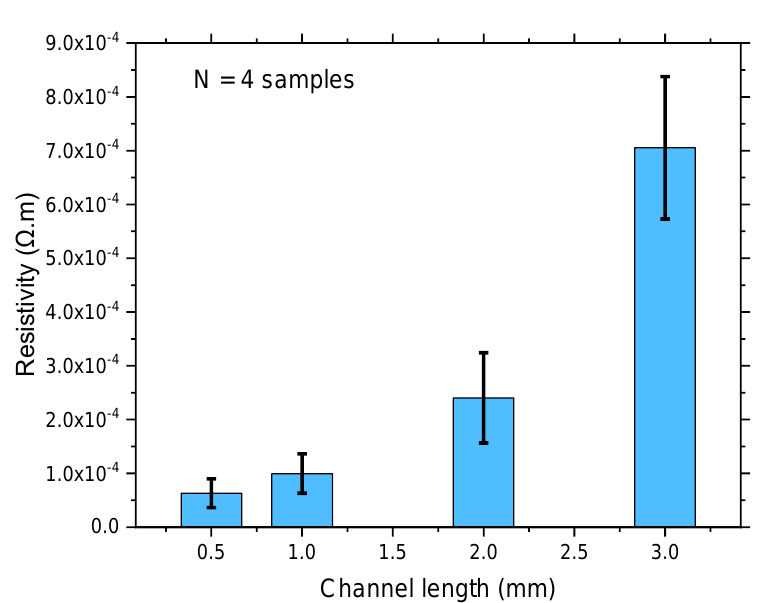
Figure 5. Comparison of the resistivity standard deviations at 0.5, 1, 2, and 3 mm channel lengths using CoMoCAT SG 65 SWCNTs.